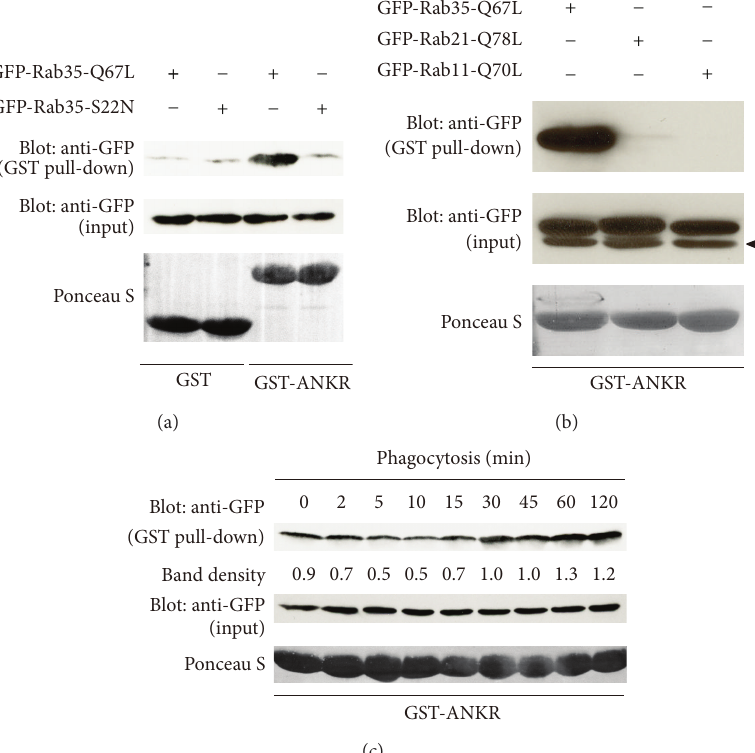
Figure 2: Rab35 is inactivated during phagocytosis of zymosan. (a) GTP-dependent association of GST-ANKR with Rab35-Q67L. COS-7 cell lysates expressing GFP-Rab35-Q67L or GFP-Rab35-S22N were incubated with GST or GST-ANKR. The proteins associated with GST or GST-ANKR were pulled down using glutathione-sepharose beads and analyzed by western blotting (top panel). The middle panel shows aliquots of total cell lysates. (b) Binding specificity of GST-ANKR. Glutathione-sepharose beads coupled with GST-ANKR were incubated with COS-7 cells lysates expressing GFP-Rab35-Q67L, GFP-Rab21-Q78L, or GFP-Rab11-Q70L. Proteins bound to the beads were analyzed by western blotting. The middle panel shows aliquots of total cell lysates. The lower band is a nonspecific band (arrowhead). (c) RAW264 cells expressing GFP-Rab35 were incubated with or without (0min) zymosan for various times at 37 ∘ C. Cell lysates were prepared and incubated with GST-ANKR. The proteins associated with GST-ANKR were pulled down using glutathione-sepharose beads and analyzed by western blotting (top panel). The middle panel shows aliquots of total cell lysates. The density of the protein bands was measured. The relative protein band intensity of GTP-Rab35 was normalized to total Rab35 (GTP-bound plus GDP-bound forms).